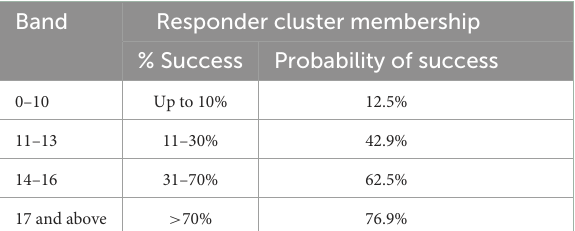
TABLE 5 Responder prediction model